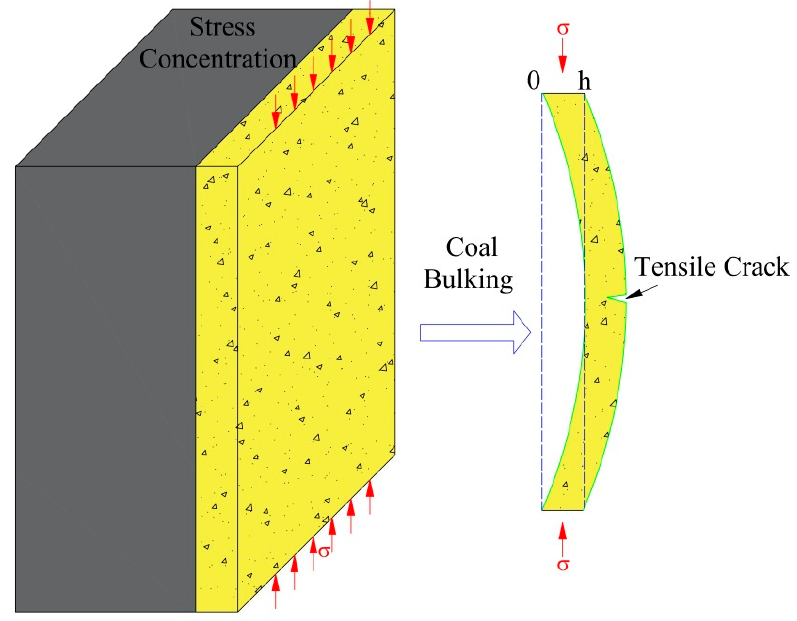
Figure 6. Schematic diagram of coal bulking caused by a concentration of stress.